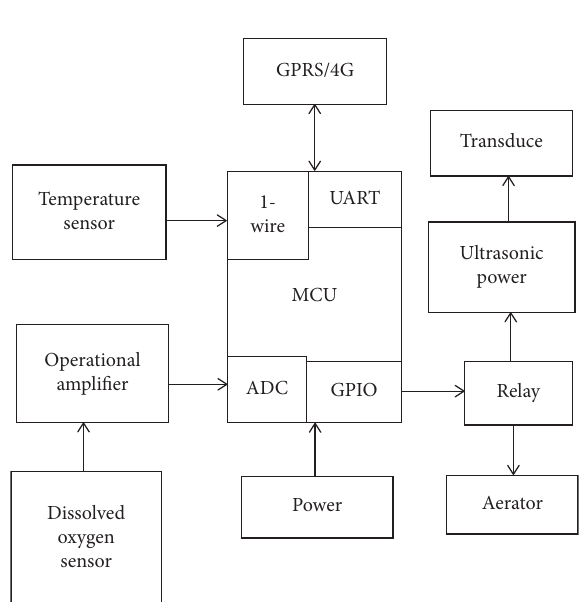
Figure 2: The composition of our